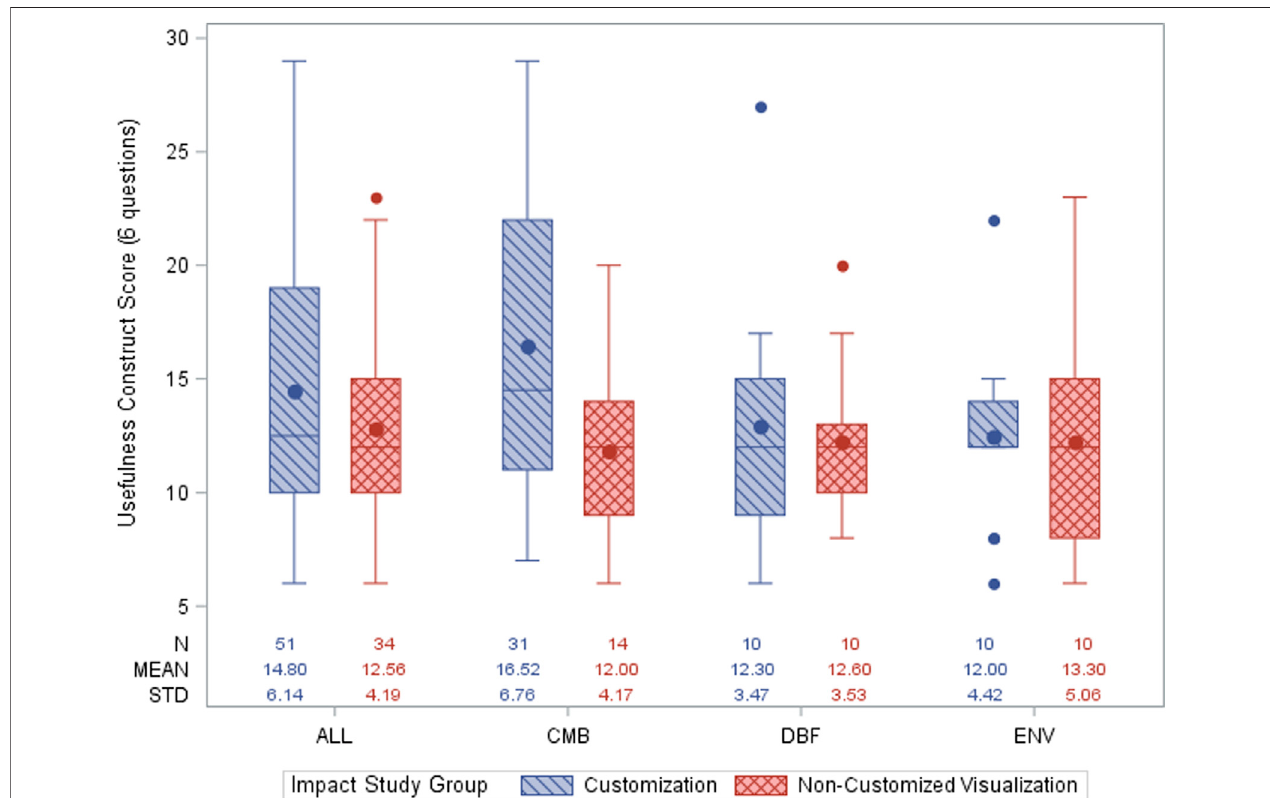
FIGURE 6 | Comparison of the usefulness construct for study groups: Overall (ALL) and across all three courses (CMB), (DBF), (ENV).